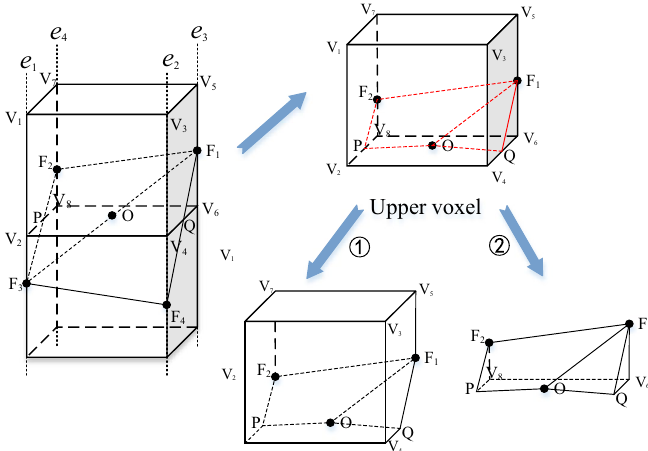
Figure 6. “2–2 adjacent type” upper voxel splitting process.